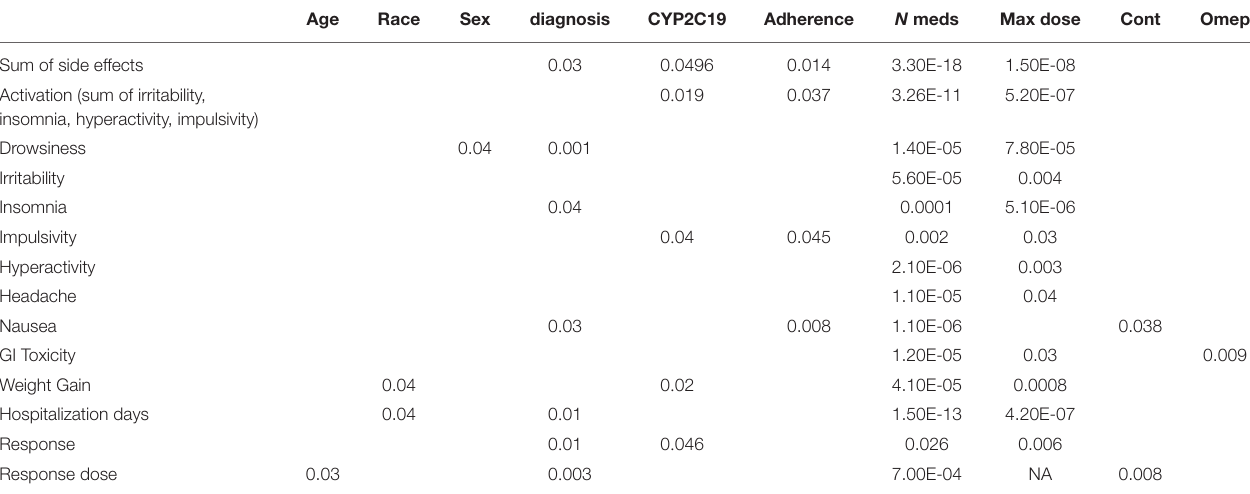
TABLE 4 | Associations of clinical variables with outcomes.